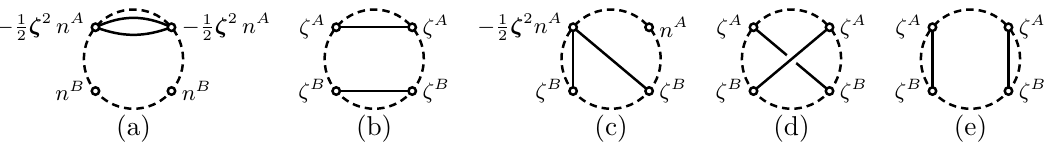
Figure 8 . Types of diagrams contributing to (6.6). Other diagrams are obtained by interchang- ing points.